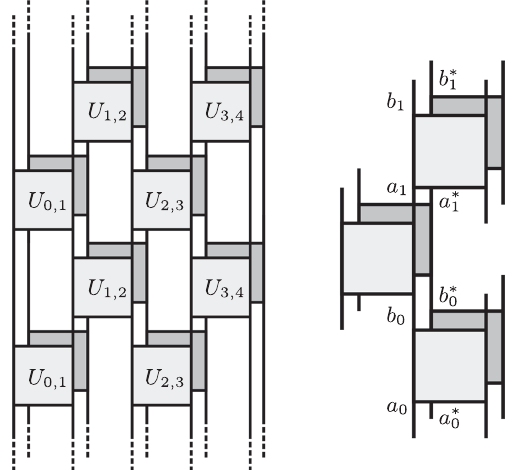
FIG. 6. Circuit diagram for the SFF of a brickwork model, with time t running vertically. Left: K ð t Þ with t ¼ 2 and open boundary conditions. The foreground (light) shows Tr W ð t Þ , and the background (dark) shows its complex conjugate. Dashed lines exiting at the top of the figure are connected to those entering from below, giving independent traces Tr W ð t Þ and Tr W (cid:3) ð t Þ . Right: segment of the doubled time evolution, high- lighting notation for forward ð a 0 b 0 … Þ and backward ð a (cid:3) 0 b (cid:3) 0 … Þ